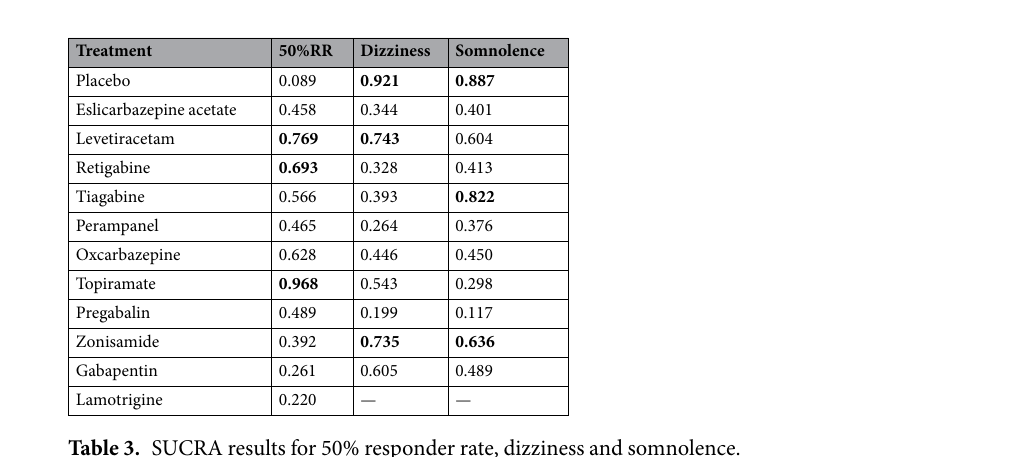
Table 3. SUCRA results for 50% responder rate, dizziness and